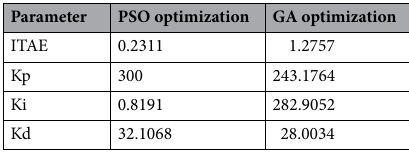
Table 4. Parameter optimization results.